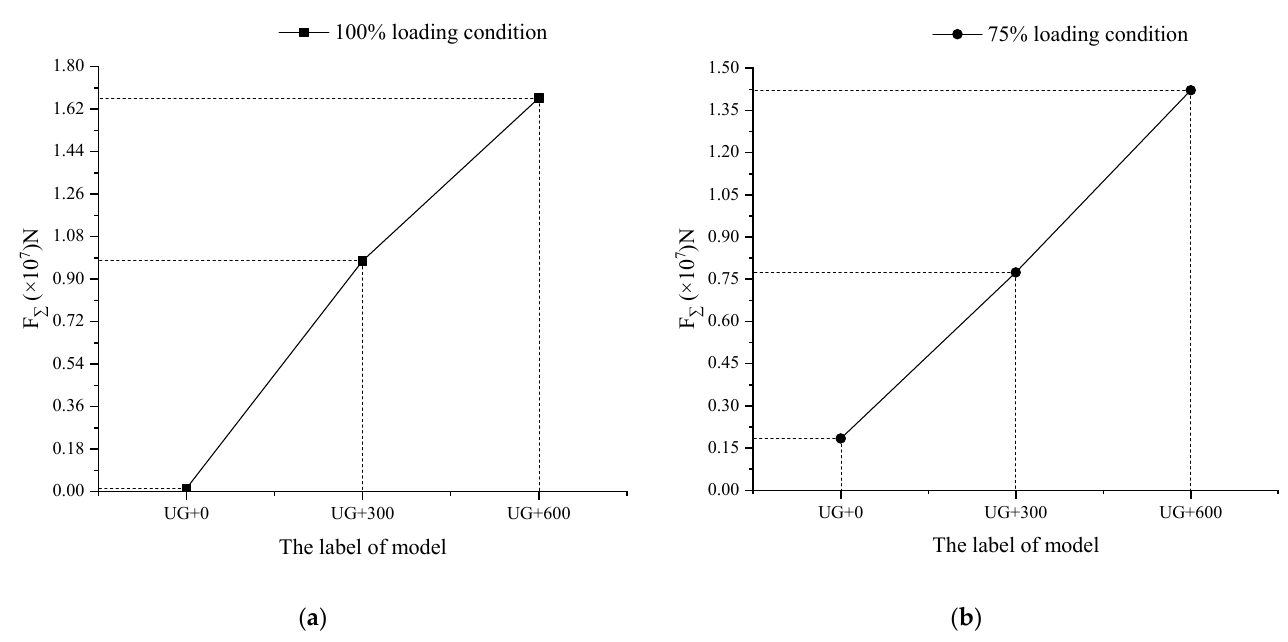
Figure 6. Comparison of resultant force. ( a ) 100% loading condition. ( b ) 75% loading condition.